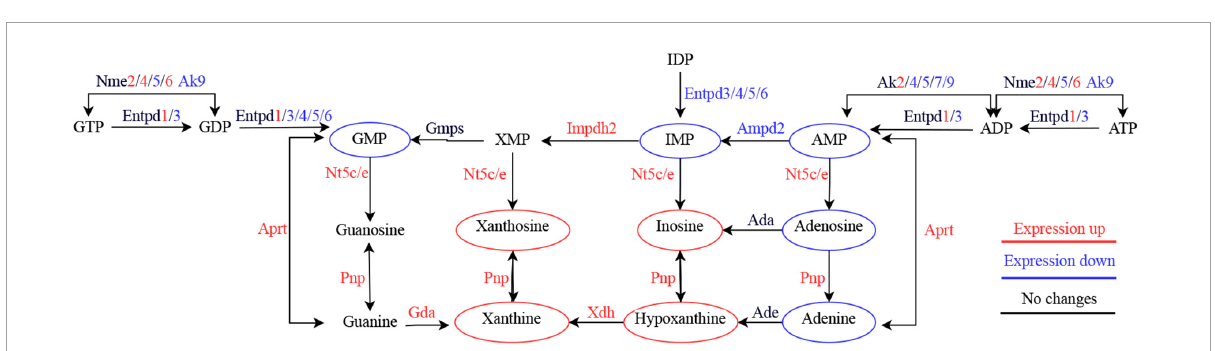
FIGURE6 Schematic diagram of this study.